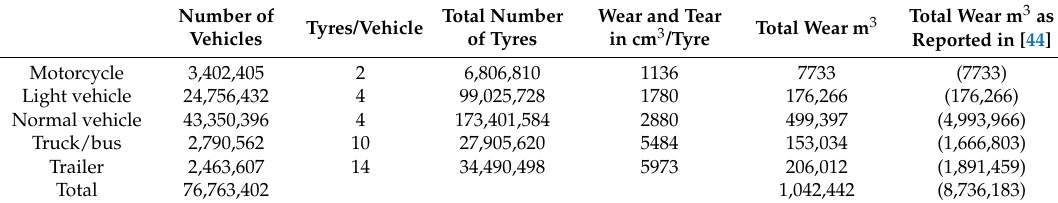
Table 8. Calculation of the amount of tyre wear and tear in Japan generated in 5 years [44]. Number of